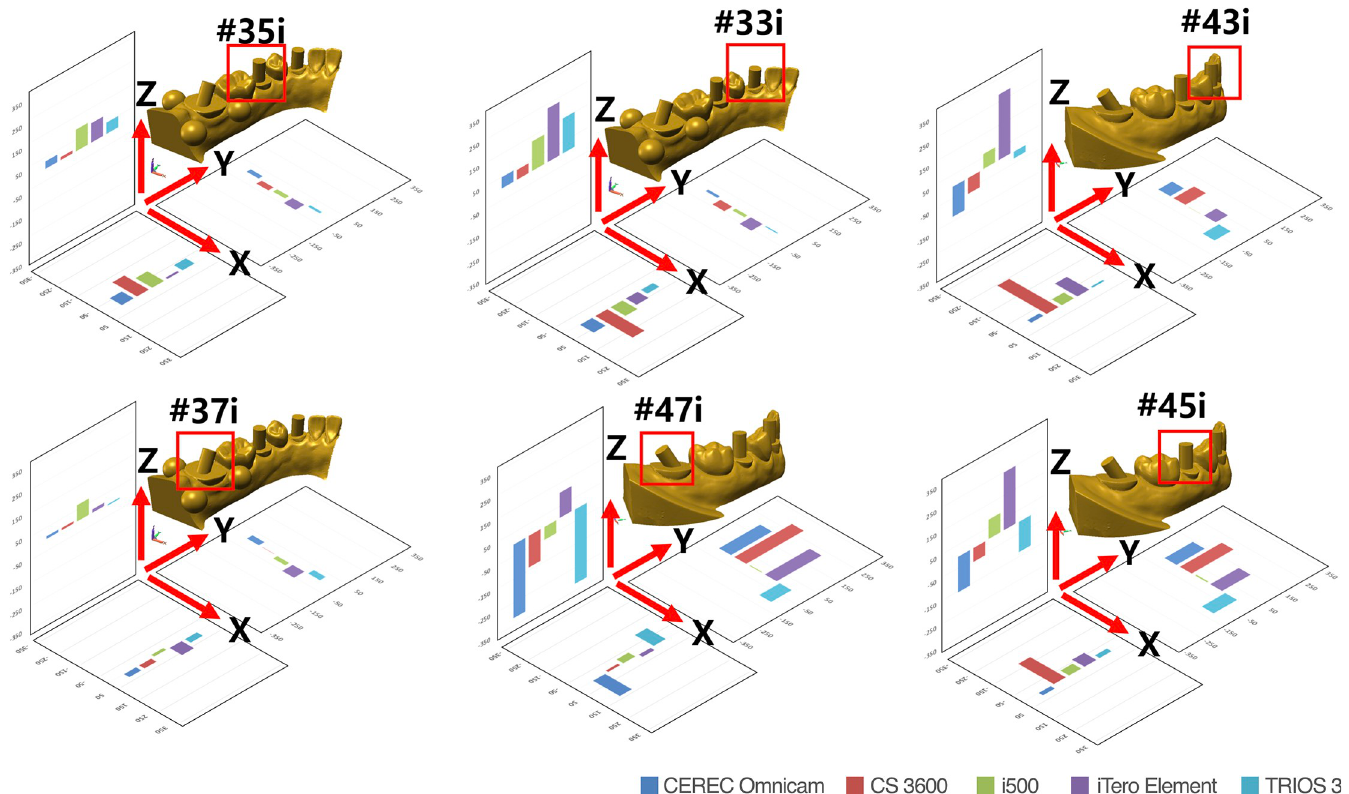
Fig 2. Trueness values ( μ m) of IOSs at each cylinder position in XYZ axes.